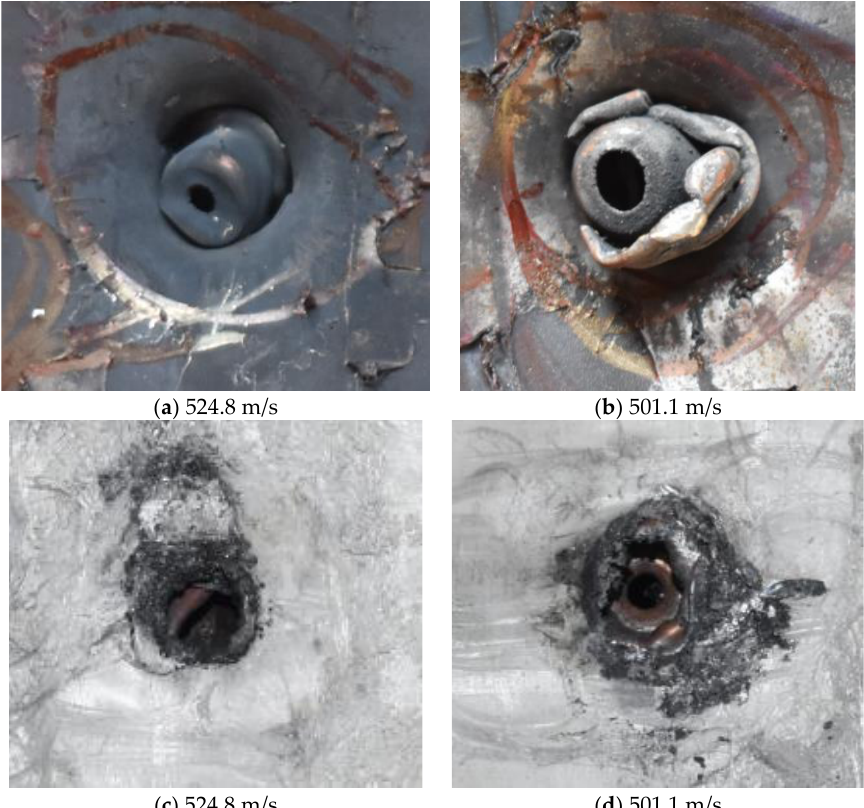
Figure 7. The striped brass jacket and lead filler in the perforation of the front sheet at different impact velocities (( a , b ) for the front view, ( c , d ) for the back view).